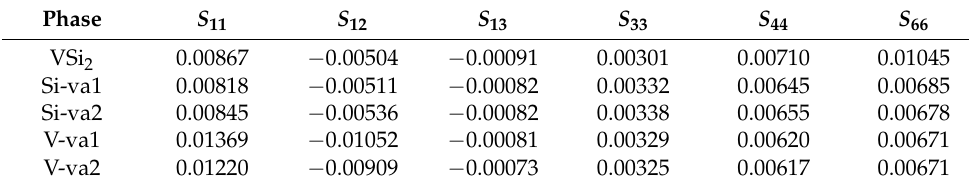
Table 3. Calculated elastic compliance constants S ij (GPa − 1 ) of C11 b -VSi 2 . Phase S 11 S 12 S